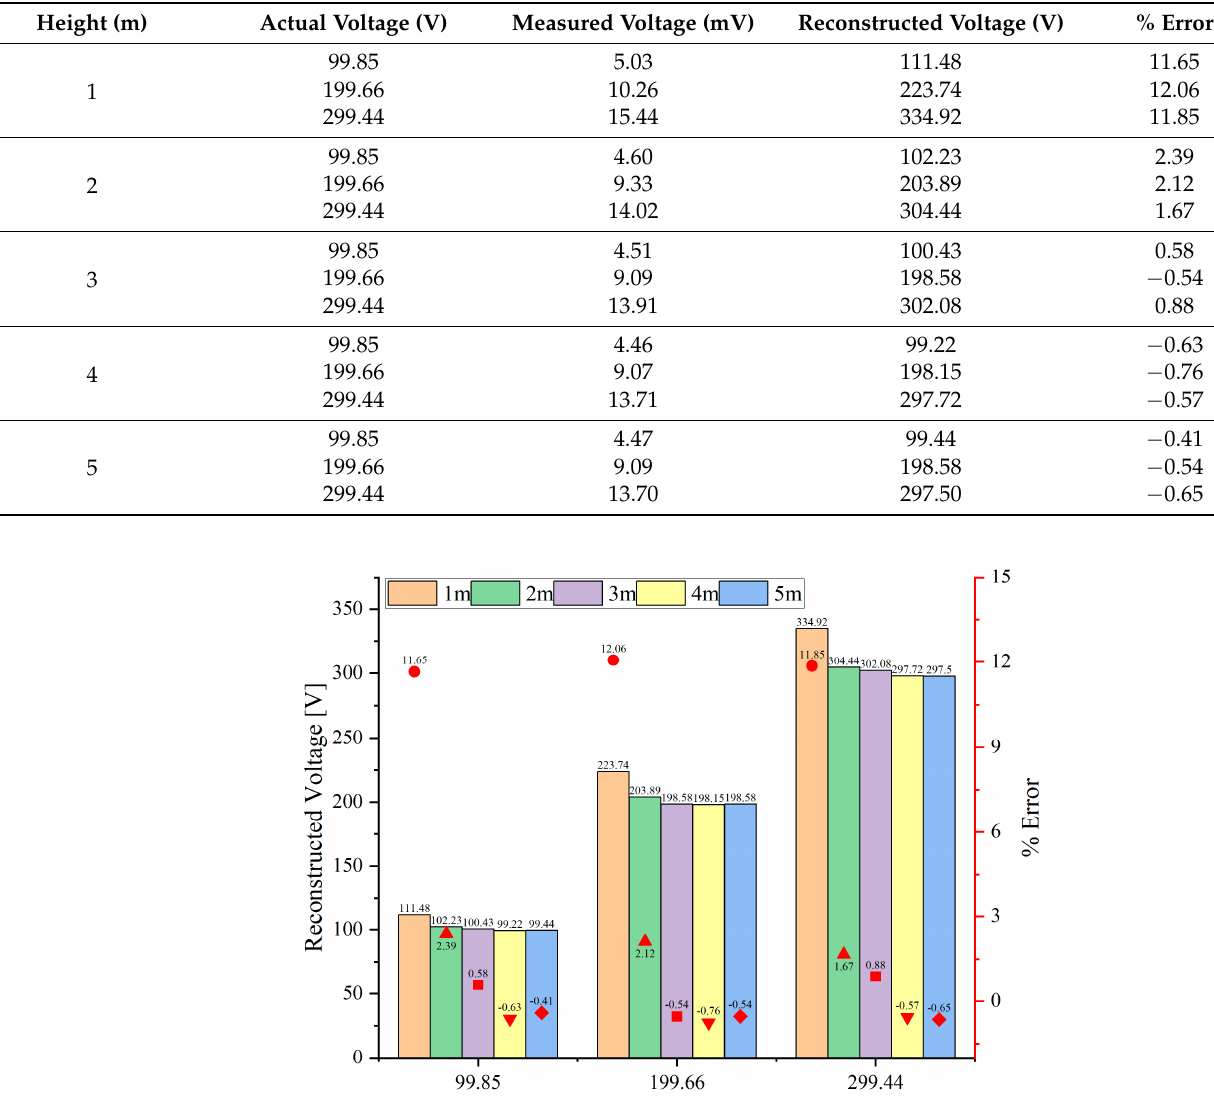
Table 8. Error characteristics of actual output voltage and reconstructed voltage at different heights .